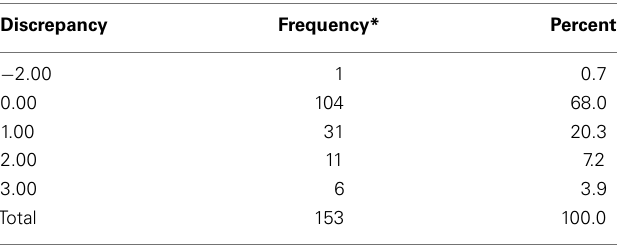
Table 5 | Number of people with a discrepancy between System Scoring and Clinician Scoring for the IVR Digit Span Backward.